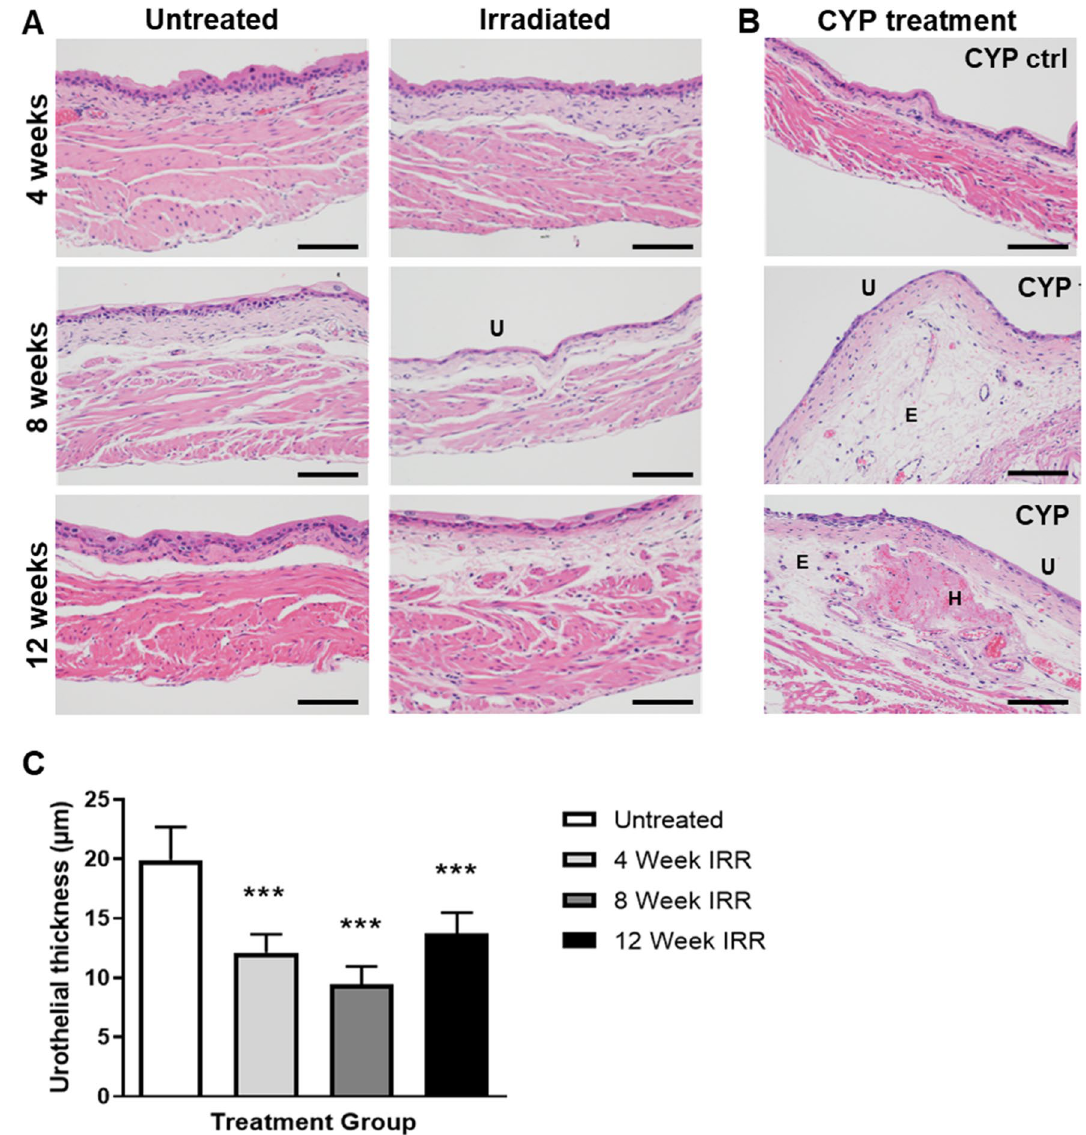
Figure 2. Irradiation induces temporary thinning of the bladder urothelium. ( A ) Untreated and irradiated bladder tissues were stained for Hematoxylin and Eosin at 4, 8 and 12 weeks after radiation treatment. ( B ) Bladders treated with cyclophosphamide (CYP), a positive control for inflammation, were stained with H&E 24 h after treatment. ( C ) Urothelial thickness was quantified for untreated bladders and 4, 8, and 12 weeks after irradiation. U urothelial thinning, E edema, H hemorrhaging; Scale bar = 100 µm; Error bar =